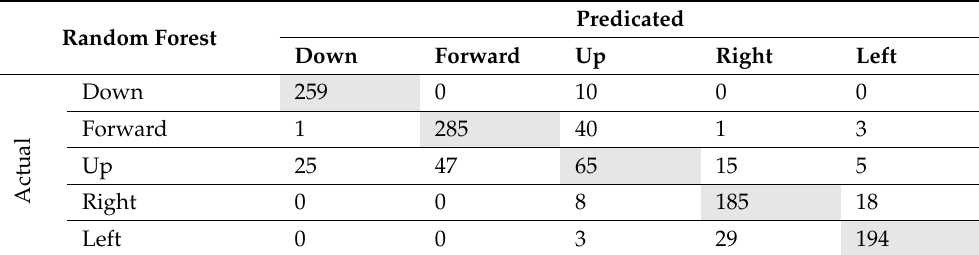
Table 3. Five-class confusion matrix for the short sensor with low placement. Rows represent actual class and columns represent predicted